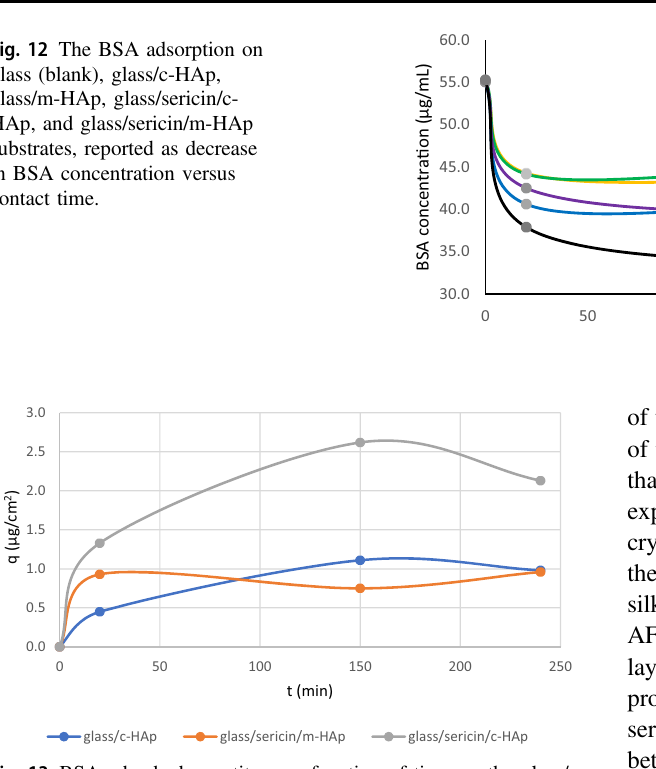
Fig. 13 BSA adsorbed quantity as a function of time on the glass/c- HAp, the glass/sericin/m-HAp, and the glass/sericin/c-HAp fi